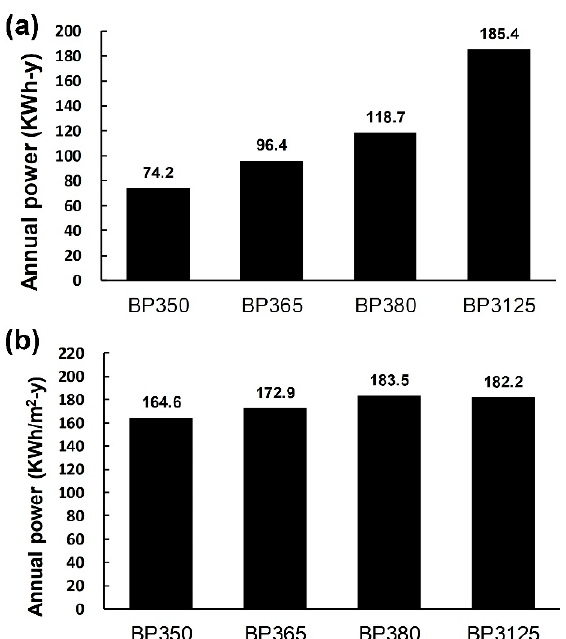
Figure 4. Simulated annual power output by the BP3 series: ( a ) Single module; ( b ) Unit area.